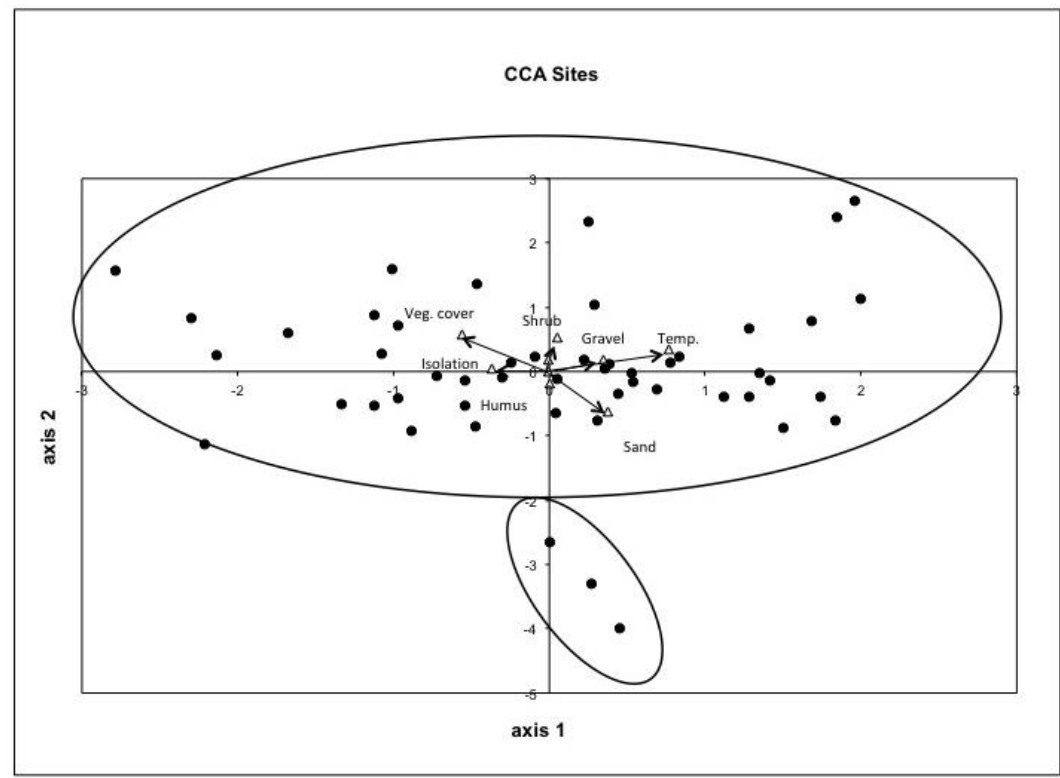
Figure 2. CCA ordination of the surface active Collembola collected with pitfall traps in 50 dry grassland sites in Eastern Austria. Four clusters and the patch and landscape variables separating the patches and clusters are shown.